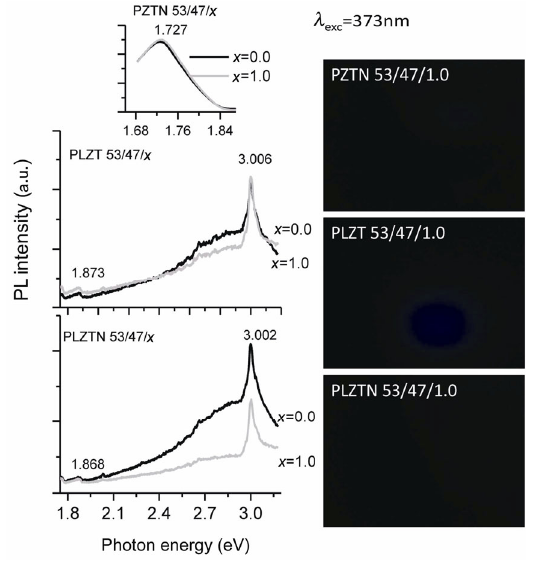
Fig. 5 PL spectra for PLZT, PLZTN, and PZTN 53/47 systems for different dopant concentration excited at 373 nm.